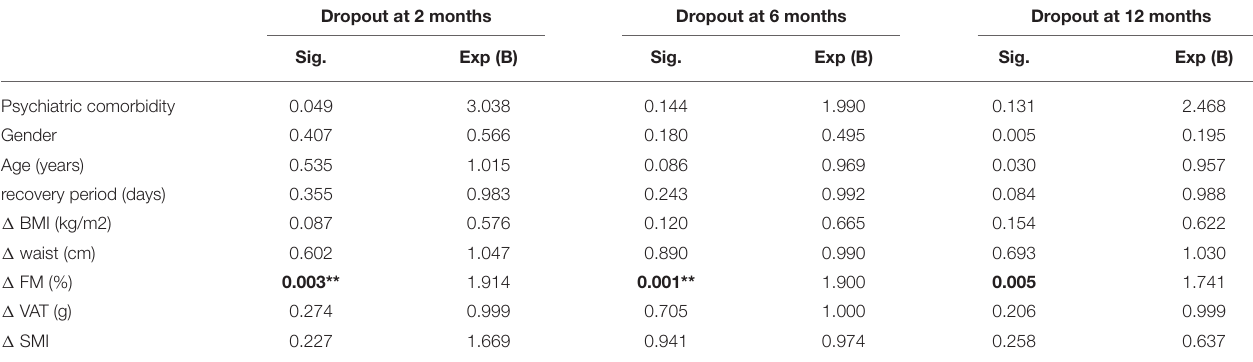
TABLE 7 | Binary regression of dropout risk at 2, 6, and 12 months considering the anthropometric markers changed during the MRP. Dropout at 2 months Dropout at 6 months